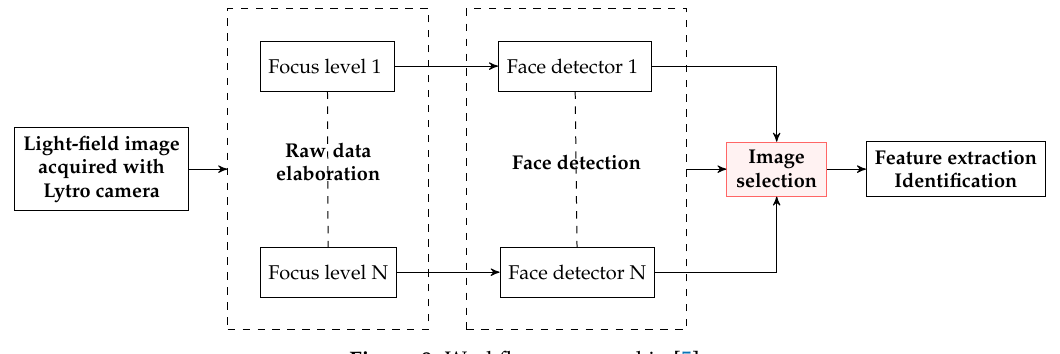
Figure 9. Workflow proposed in [5]